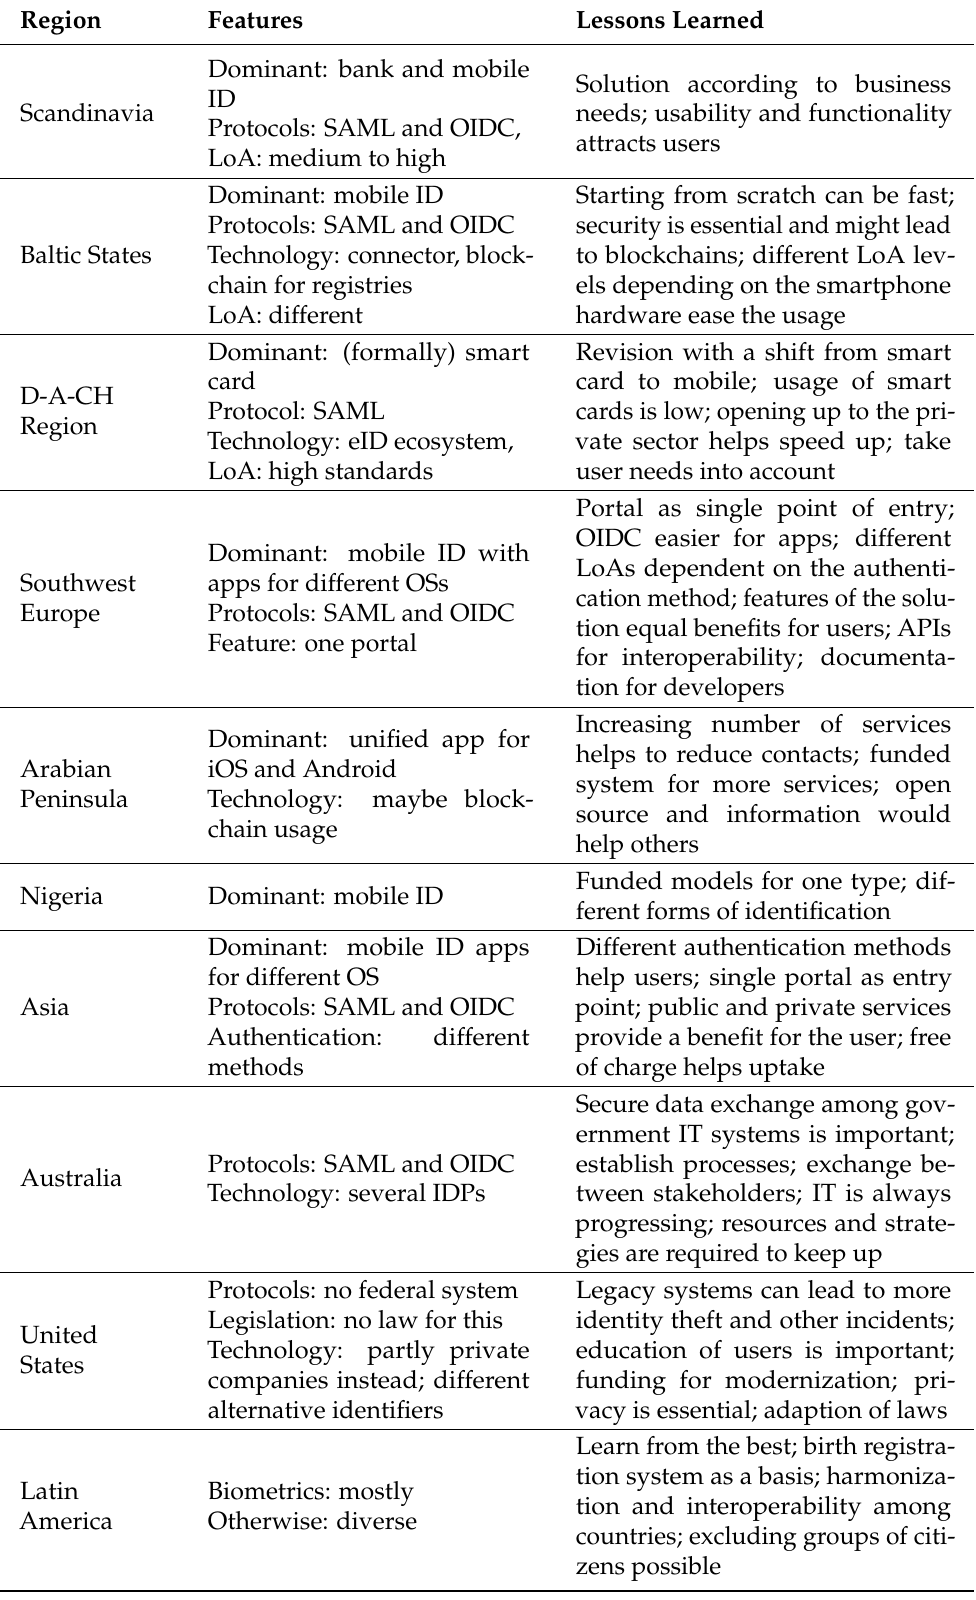
Table 1. Summary of national